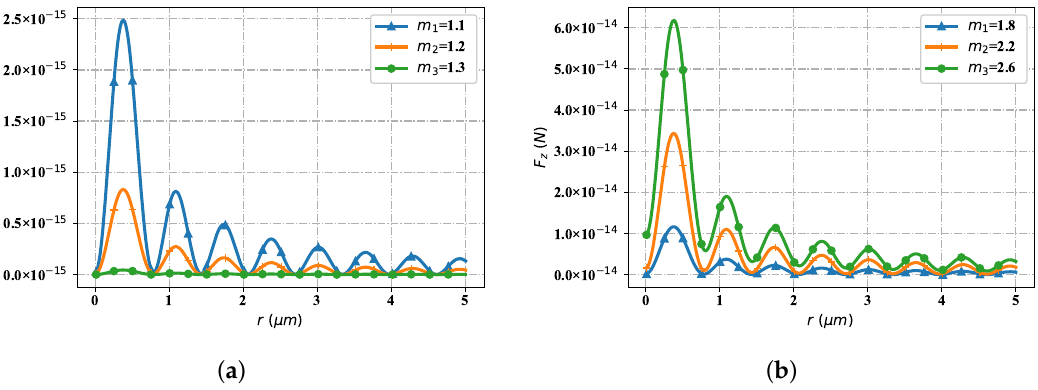
Figure 14. The distribution of F z under differet refractive indices,including the lower indices and uper indices. ( a ) F z with low indices; ( b ) F z with uper